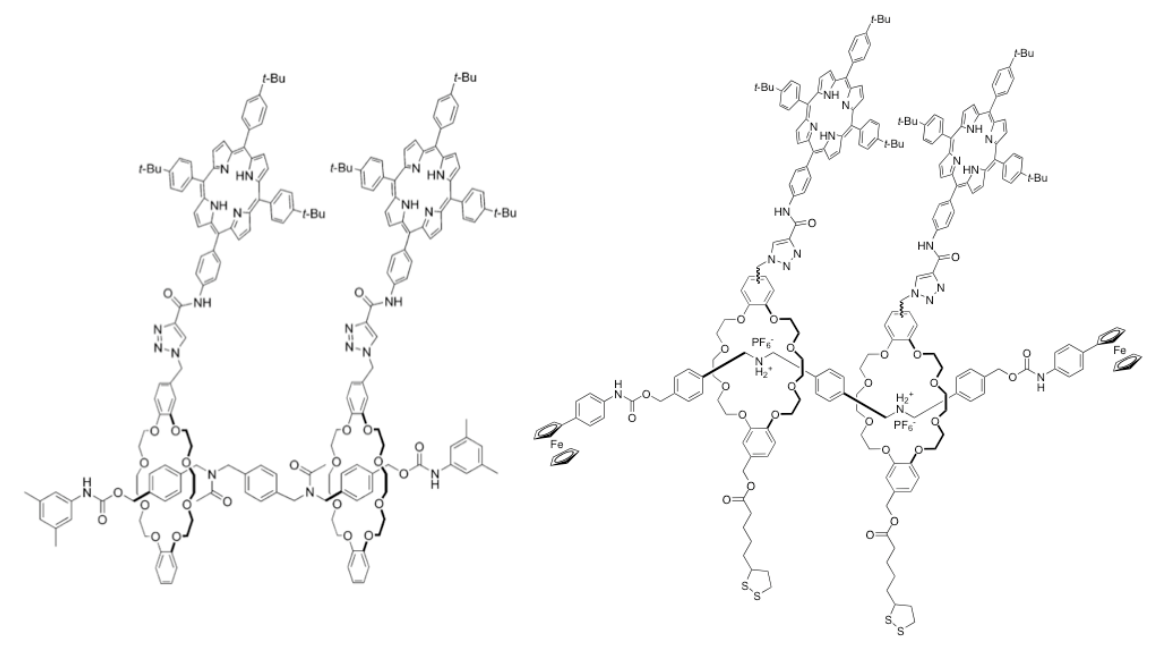
Figure 4. Supramolecular host for fullerenes based on rotaxane